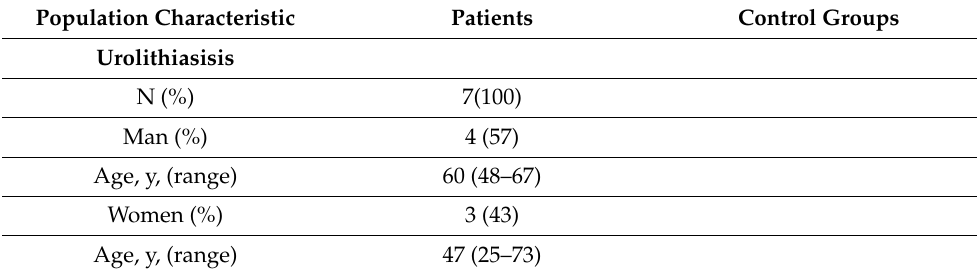
Table 1. Cont. Population Characteristic